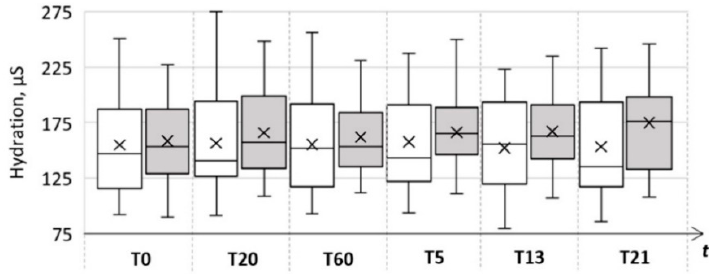
Figure 2. Hydration measurements of the control and test area in the short-term and long-term study (grey boxes are test values, white are control). Table 1. Mean values and standard deviations of elasticity, hydration, transepidermal water loss (TEWL) and pH ( n = 30) in test and control areas.